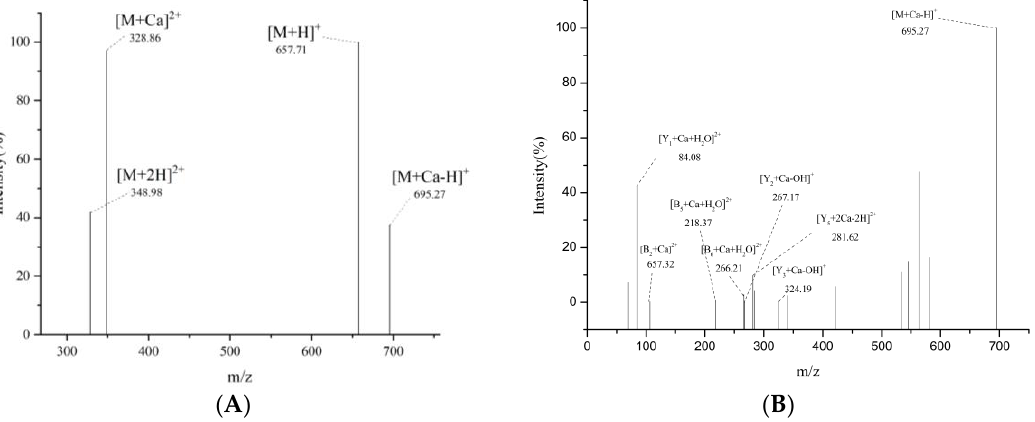
Figure 7. Identification of the binding sites of DGPSGPK-Ca. ( A ) Primary mass spectrum; ( B ) secondary mass spectrum.